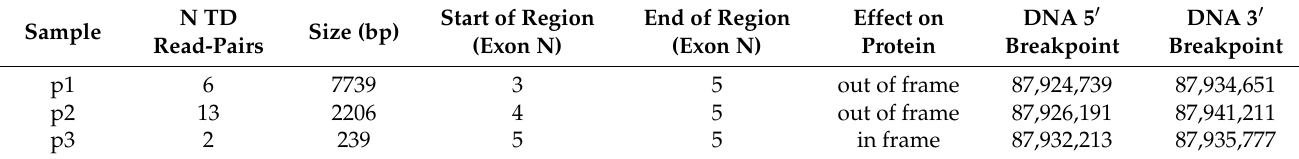
Table 2. Recurrent TDs in PTEN . Breakpoint coordinates are based on human reference genome GRCh38.